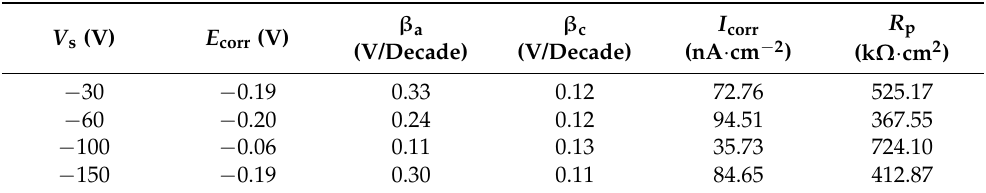
Table 2. Corrosion properties obtained from the dynamic potential polarization curves in 3.5 wt.% NaCl aqueous solution.